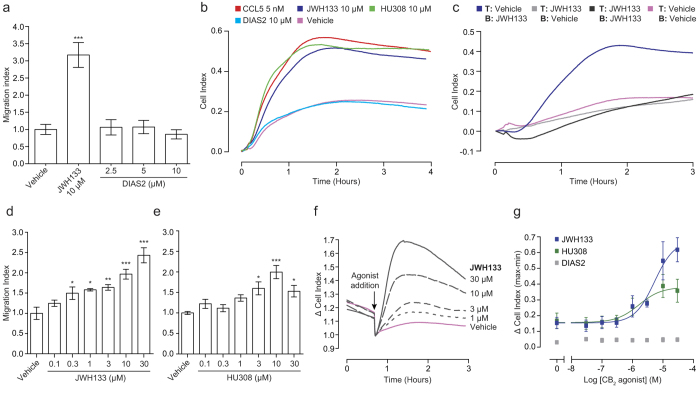
The CB2 selective agonists JWH133, HU308 and DIAS2 differ in their ability to induce the directional migration of murine PECs. (A) Bio-gel elicited murine PECs were placed into the top well of a modified 96 well Boyden chamber (8 μm pore size) and allowed to migrate towards vehicle or cannabinoid for 4 hours at 37 °C, 5% CO2. JWH133 (10 μM) significantly induced macrophage chemotaxis; however DIAS2 had no effect on macrophage migration. Data are mean± SEM, n = 3 biological replicates. (B-E) Bio-gel elicited murine PECs were placed into the upper chamber of a CIM-16 plate and allowed to migrate for 3-4 hours at 37 °C, 5% CO2 towards indicated compounds. (B) Real-time chemotaxis analysis confirmed that JWH133 and HU308, but not DIAS2 (all 10 μM), elicit PEC chemotaxis. (C) Chemokinetic analysis, comparing all combinations of vehicle or cannabinoid (10 μM) in the top (T) and bottom (B) chambers, demonstrated that JWH133 induced true chemotaxis. Data are mean real-time traces from one experiment with 4 technical replicates per condition, and are representative of 2 independent biological replicates. (D,E) Concentration response analysis found that both JWH133 and HU308 elicit PEC chemotaxis in a concentration dependent manner. Data are mean ± SEM, n = 4 biological replicates with 3-4 technical replicates per condition. (F,G) Bio-gel elicited PECs were placed into a 96 well E-plate allowed to adhere for 2-3 hours at 37 °C, 5% CO2. Afterwards, cells were stimulated with either vehicle or cannabinoid at the indicated concentration. (F) Representative raw traces showing cell responses to JWH133 (30, 10, 3 and 1 μM). Data are mean traces from one experiment with 2-3 technical replicates per condition. (G) Concentration response quantification demonstrates that JWH133 and HU308 caused macrophage cytoskeletal rearrangement in a concentration dependent manner, with EC50 values of 5.3 and 1.6 μM. Data are mean ± SEM, n = 3 biological replicates with 2-3 technical replicates per condition. Statistical analysis was conducted by one-way ANOVA with Dunnett’s multiple comparisons correction. * P < 0.05, ** P < 0.01 *** P < 0.001, comparing all samples to vehicle control.